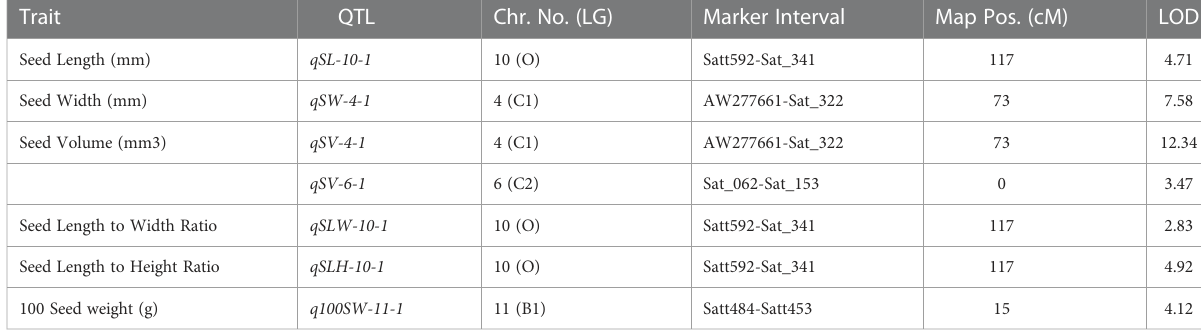
TABLE 3 Consistent QTLs for yield-related traits discovered in both F 2 and F 2:3 mapping populations derived from AGS 457 X SKAF 148. Trait QTL Chr. No. (LG) Marker Interval Map Pos. (cM) LOD